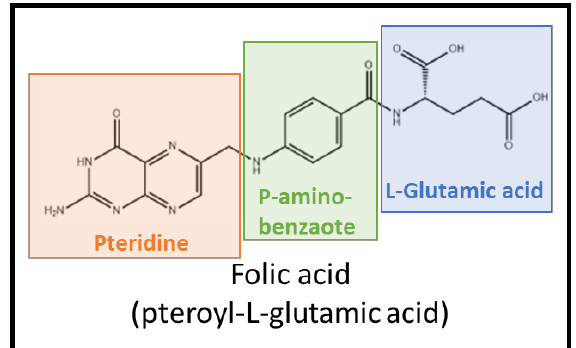
Figure 1. Summary of the type of targeted medicines that have been approved by FDA and/or EMA.